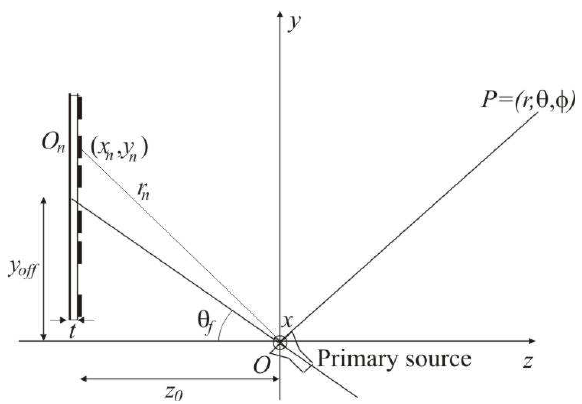
FIGURE 1. Stages of RA synthesis approach.